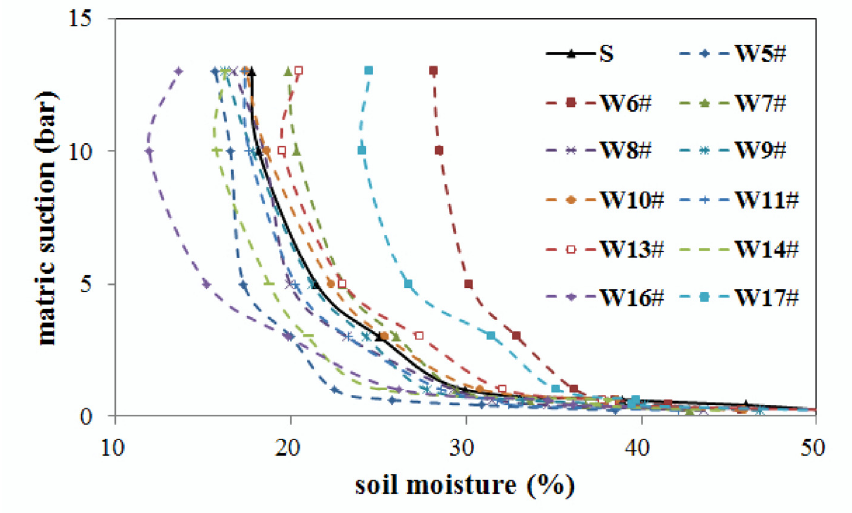
Figure 6. Soil moisture characteristic curves of the SoilNET and WaterNET samples. S means the measurement sample at SoilNET and W*# means the samples at